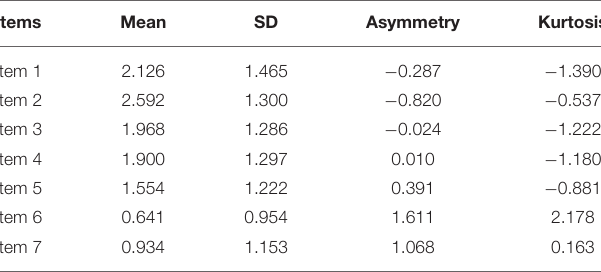
TABLE 1 | Preliminary analysis of the items of the FAT-LAT-COVID-19 scale.